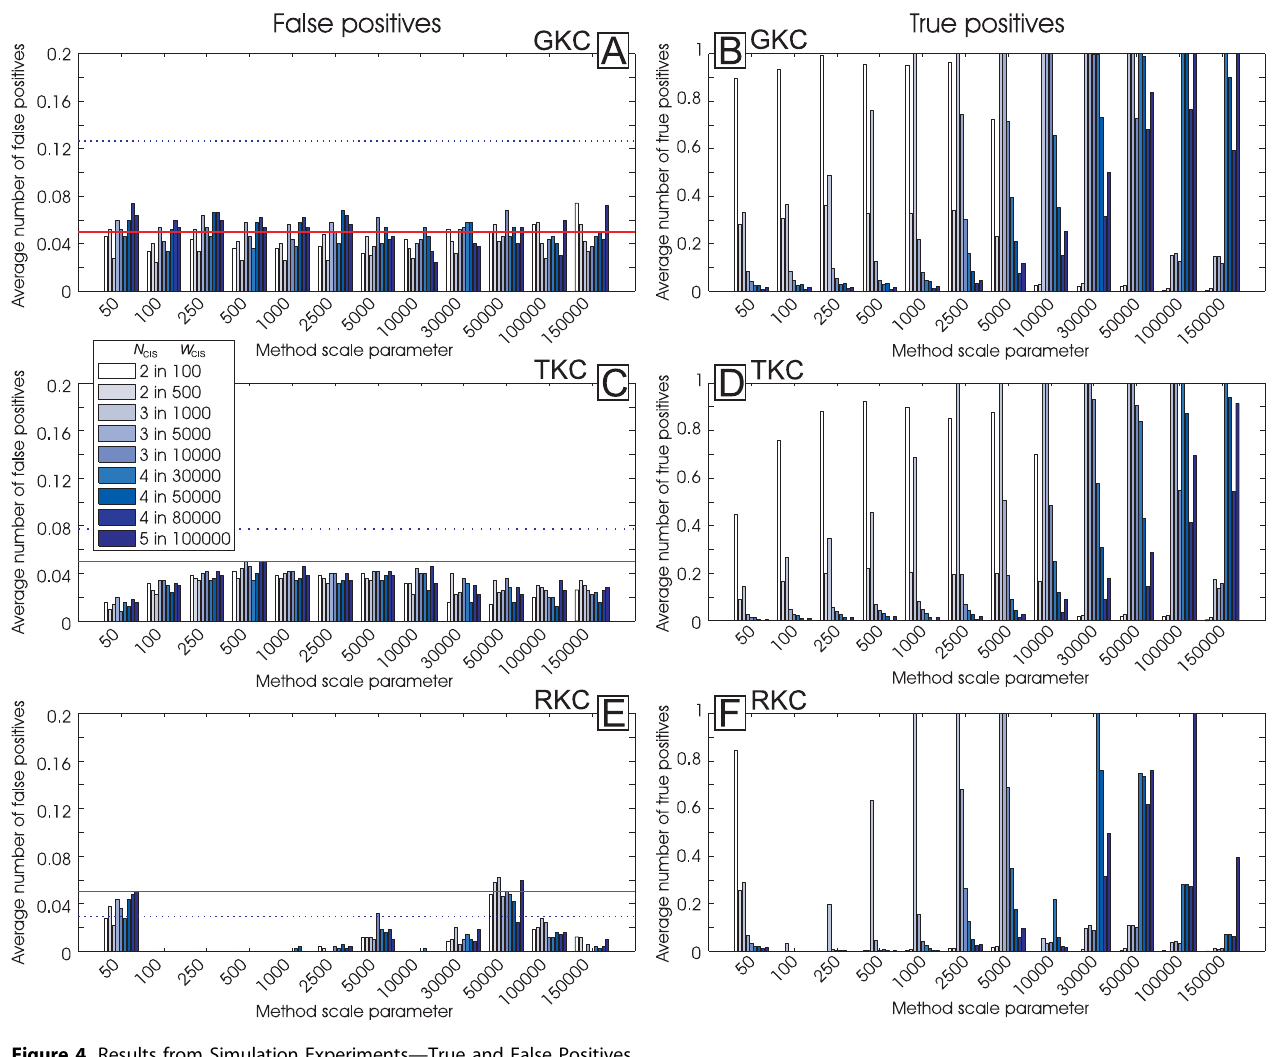
Figure 4. Results from Simulation Experiments—True and False Positives (A,B) Results for the GKC applied to artificial data. (C,D) Results for the TKC. (E,F) Results for the RKC. The horizontal solid lines in (A), (C), and (E) show the 5% significance level, the dotted lines show the average number of csFPs. The legend shows the different simulated CISs, stating the number of insertions N CIS that fall within the CIS of width W CIS